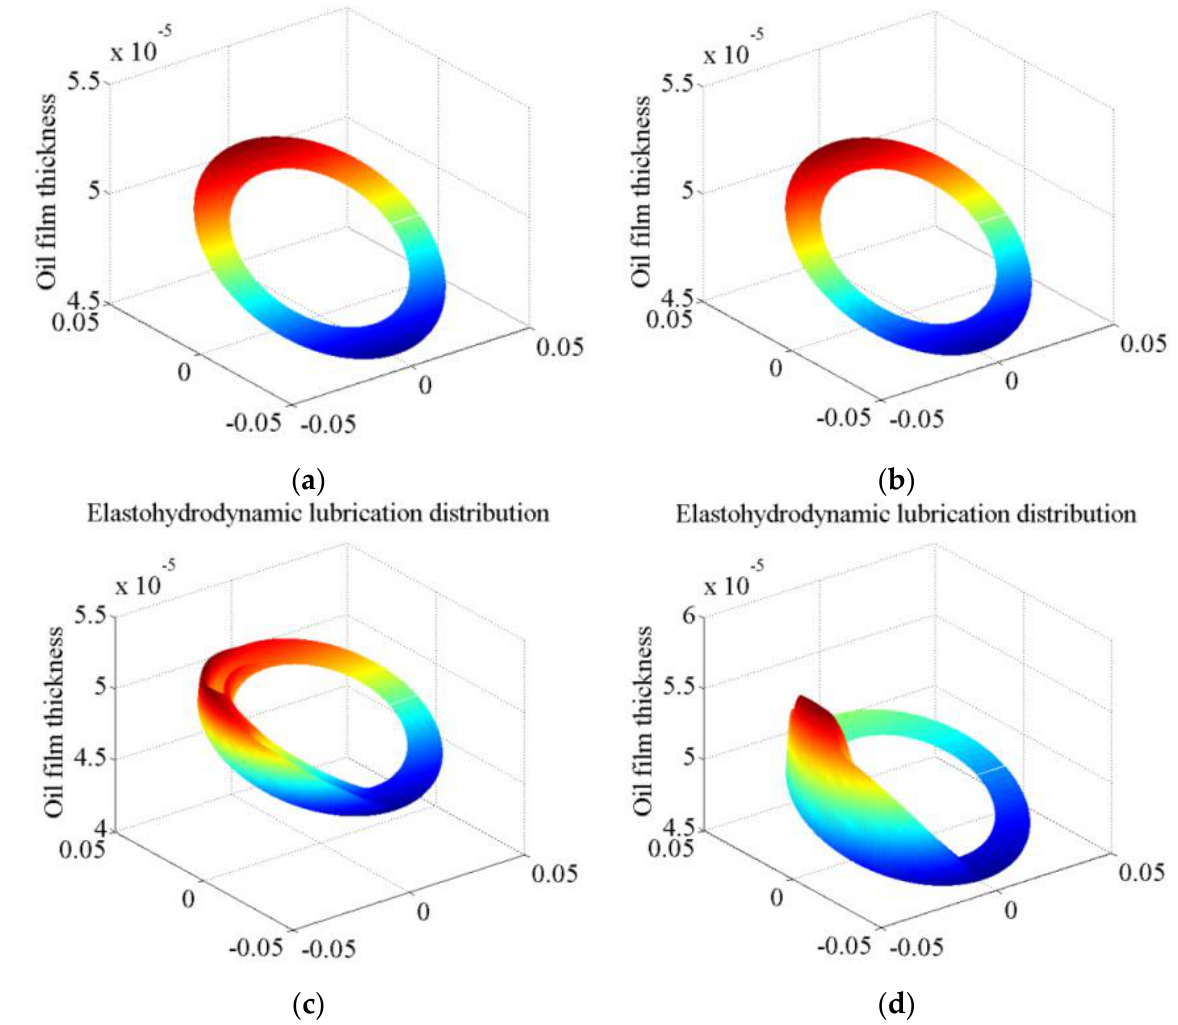
Figure 8. Effect of the velocity of rotation on the oil film clearance under elastic deformation. ( a ) ω = 2000 rpm; ( b ) ω = 4000 rpm; ( c ) ω = 6000 rpm; ( d ) ω = 8000 rpm.